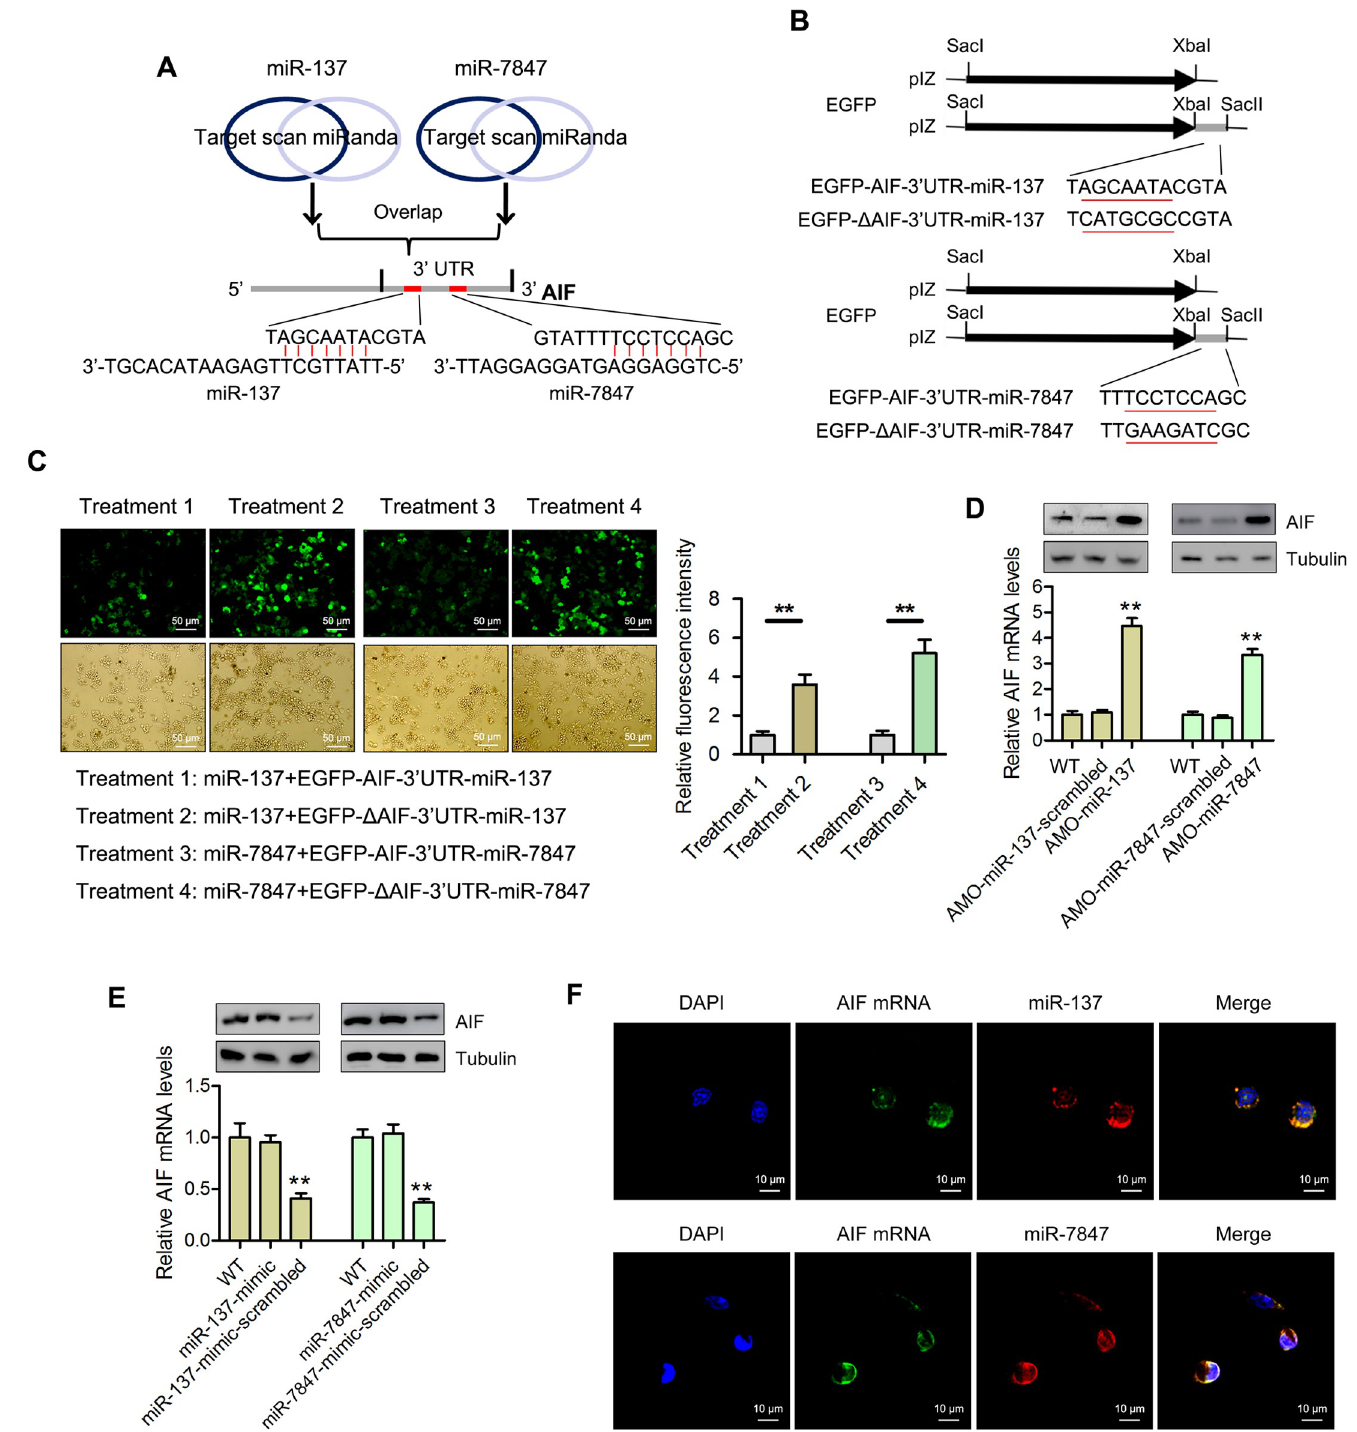
Fig 4. AIF is a direct downstream target for both miR-137 and miR-7847 in mud crab. (A) Target gene prediction of miR-137 and miR-7847 with two bioinformatics tools, as predicted, the 3’UTR of AIF could be simultaneously targeted by miR-137 and miR-7847. (B) The construction of the wild-type and mutated 3’UTRs of AIF. The sequences targeted by miR-137 and miR-7847 were underlined. (C) The direct interactions between miR-137, miR-7847 and AIF in insect cells, S2 cells were co-transfected with miR-137, miR-7847 and the indicated constructed plasmids for 48 h, then the relative fluorescence intensities were evaluated. (D) The effects of miR-137 and miR-7847 silencing on the expression levels of AIF in mud crab, AMO-miR-137 and AMO-miR-7847 were injected into mud crab separately, 48 h later, the mRNA and protein expression levels were examined. (E) The effects of miR-137 and miR-7847 overexpression on the mRNA and protein expression